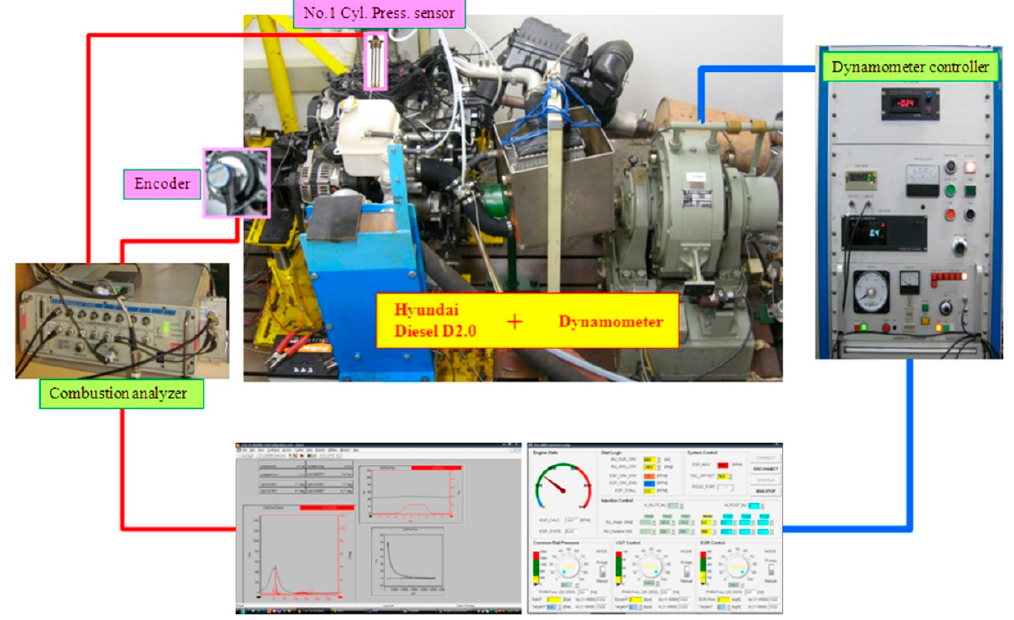
Figure 1. Engine and engine dynamometer.